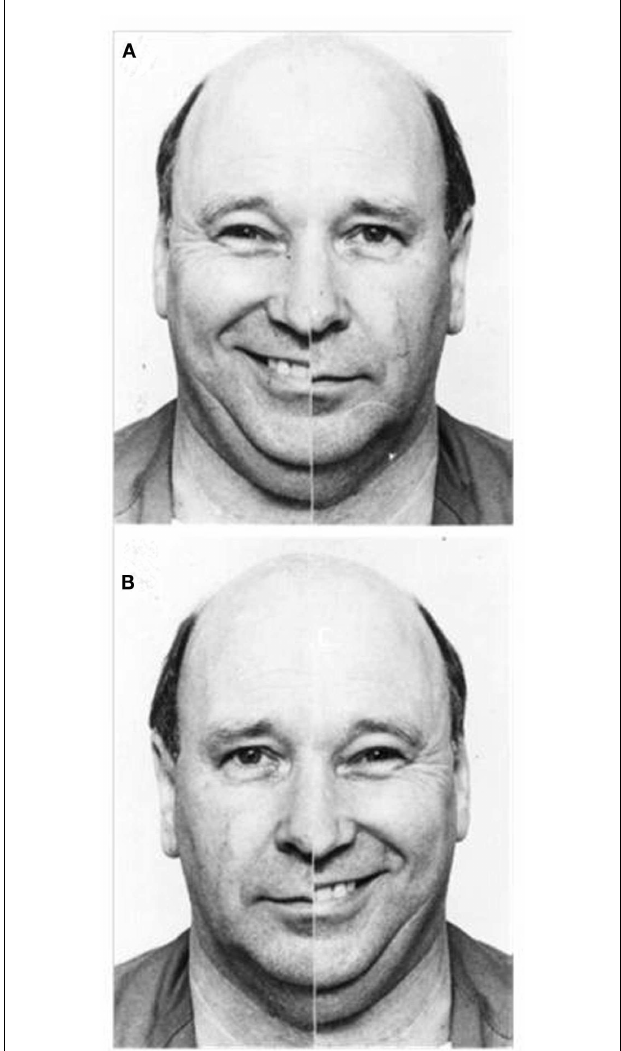
FIGURE 2 | Examples of emotional/neutral chimeric face stimuli; people tend to select the image in which emotion is presented in the left visual field (A) as more expressive than the identical image reversed to show emotion in the right visual field (B) (Reprinted from Failla et al., 2003, Copyright with permission from Elsevier) .